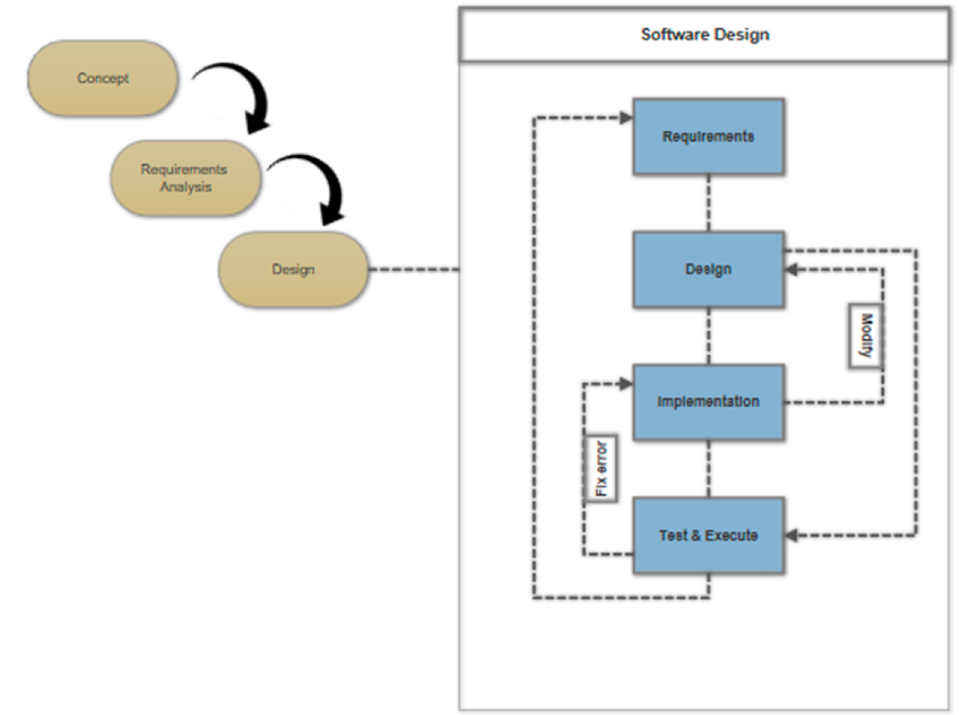
Figure 10. An iteration cycle in the software design phase [31].